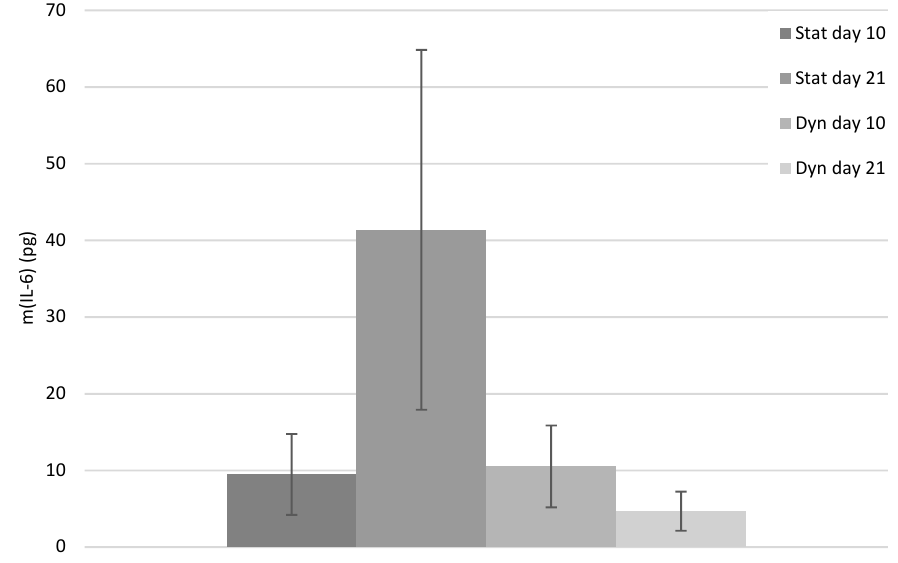
Figure 7. IL-6 amount (pg) averaged over the three series for the static and dynamic groups at days 10 and 21.